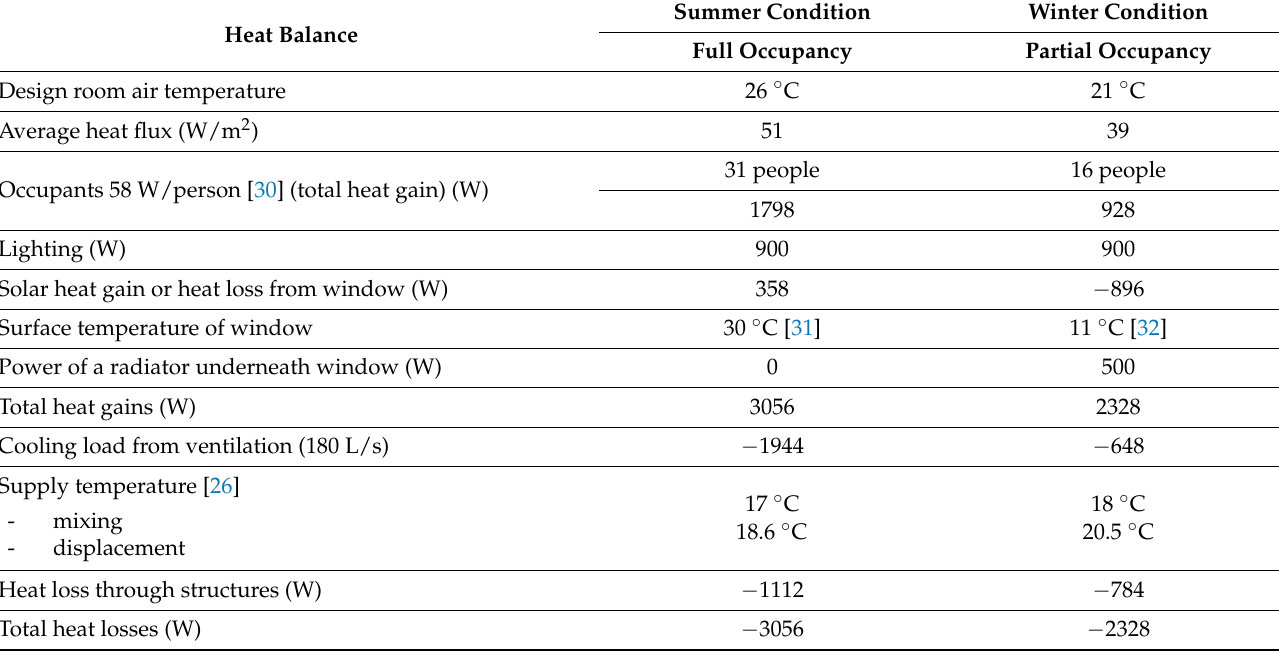
Table 2. Heat balance of the simulated whole classroom